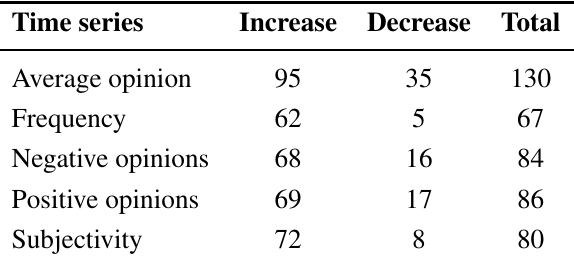
Table 3. Number of detected events by bursting time series (note that one event can contain multiple parallel